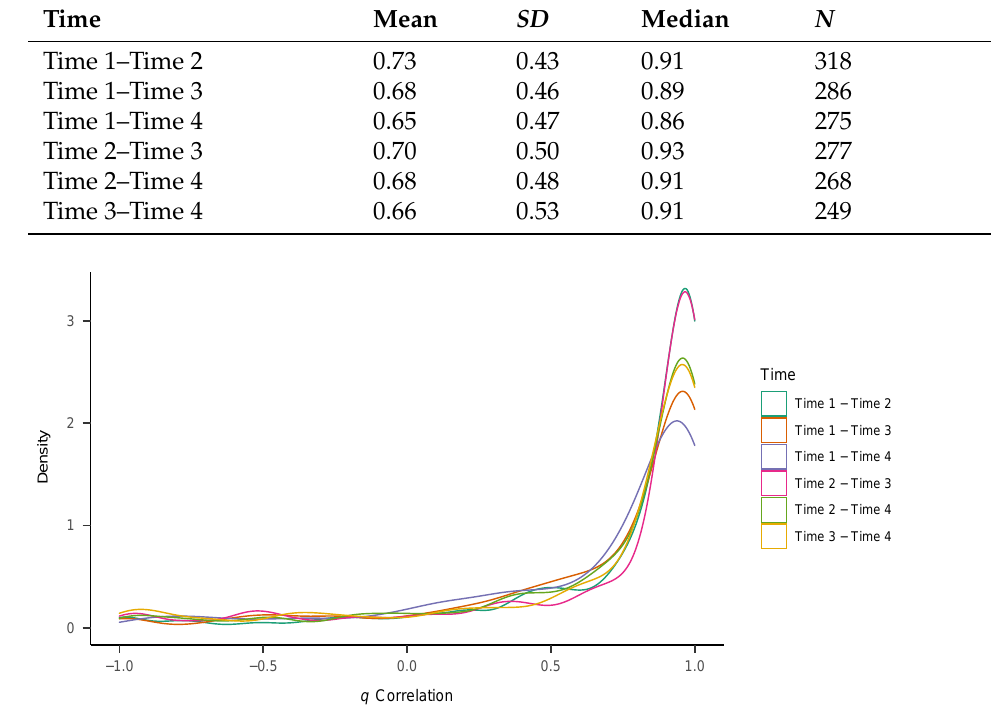
Figure 6. Density plots of q